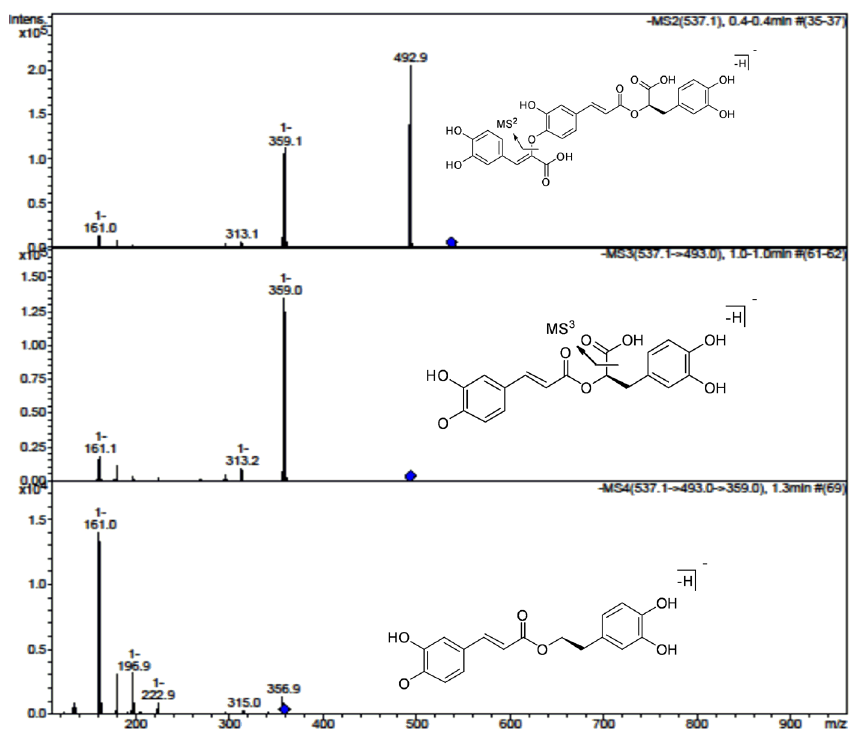
FIGURE 5 - ESI-MSn spectrum (negative ion mode) of melitric acid A ( 14 ), and proposed fragmentation